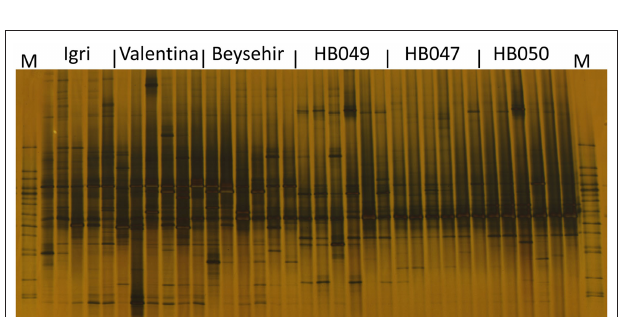
FIGURE 5 | Fungal rhizosphere communities of elite cultivars (Igri, Valentina, and Beysehir) and ancestral genotypes (HB049, HB047, and HB050) of barley, analyzed by denaturing gradient gel electrophoresis of internal transcribed spacer (ITS) fragments ( n = 6 replicate fingerprints per genotype, each replicate sample was derived from microbial extracts of roots and adhering soil of two plants). M: a marker of cloned ITS variants.